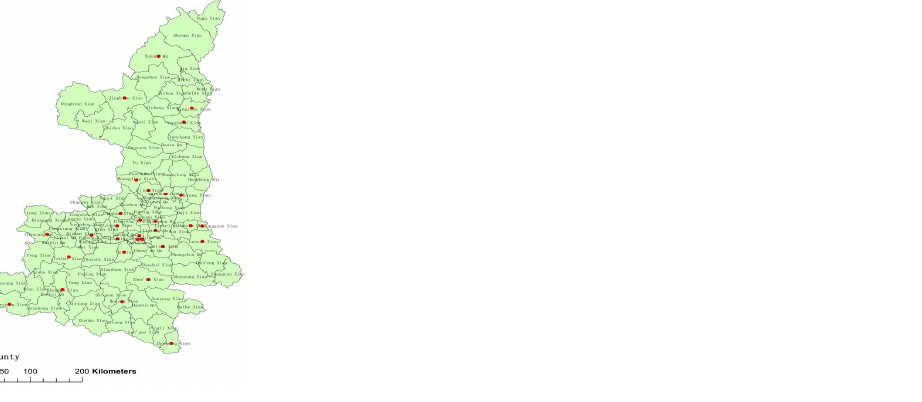
Figure 1. Distribution of 30 county-level settings selected from 10 cities in Shaanxi province.